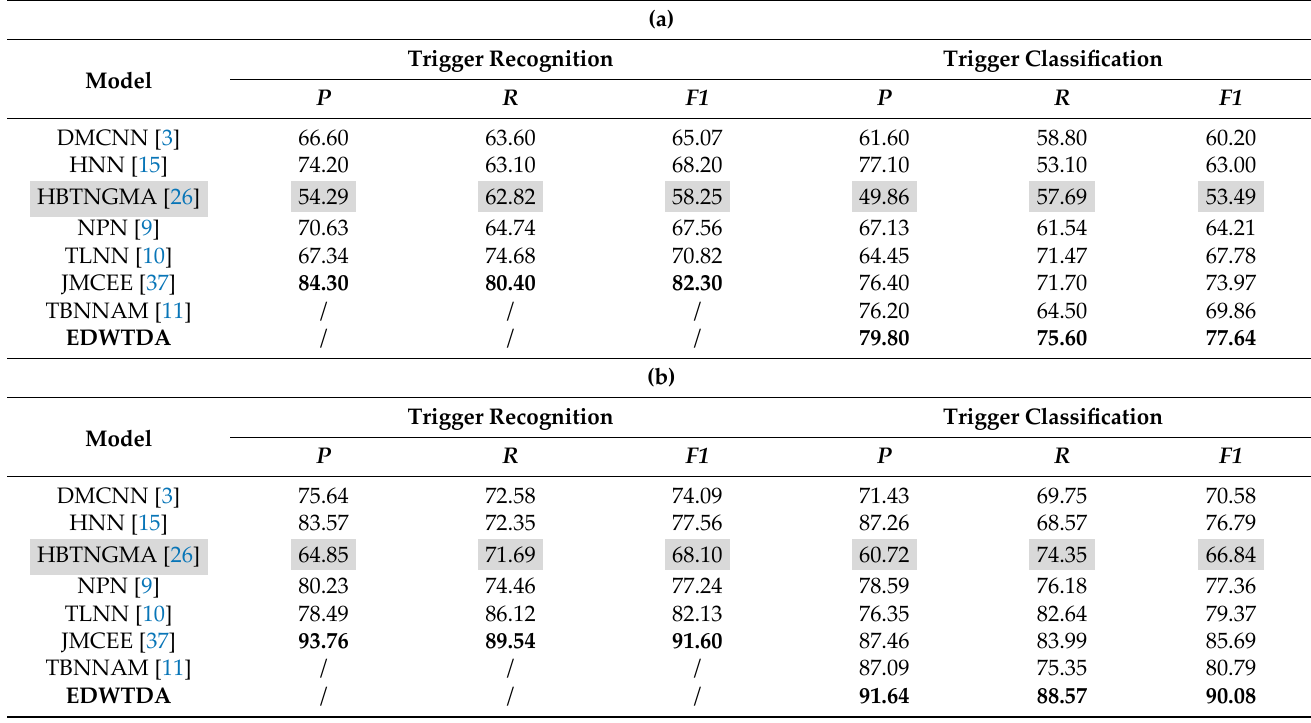
Table 6. Comparison of experimental results of different event detection methods. (a) ACE 2005 dataset. (b) Dam safety operation log